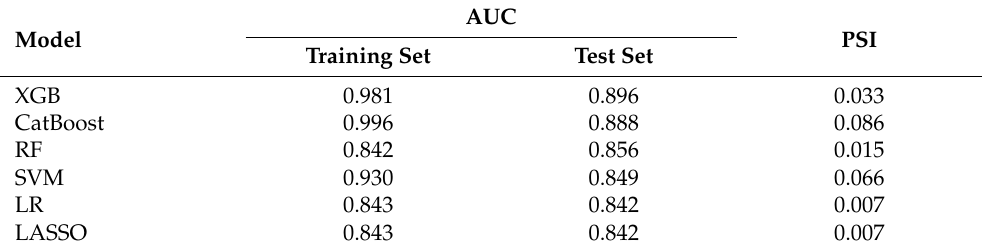
Table 6. Evaluation of fitting effect of each model.